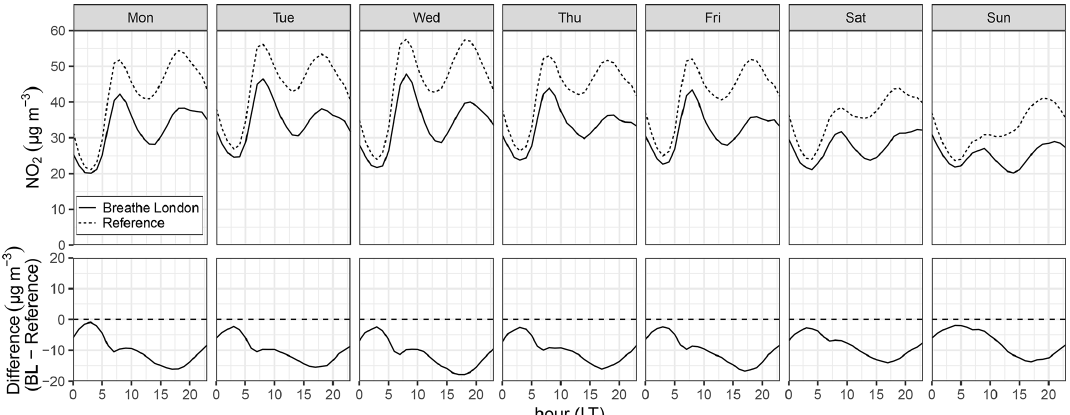
Figure 5. Network mean diurnal and day-of-week NO 2 concentration patterns in Greater London, as measured by the BL ( n = 99) and reference ( n = 105) networks during the pre-Covid-19 period of the BL project (1 October 2018 through 29 February 2020). Bottom panel shows difference between